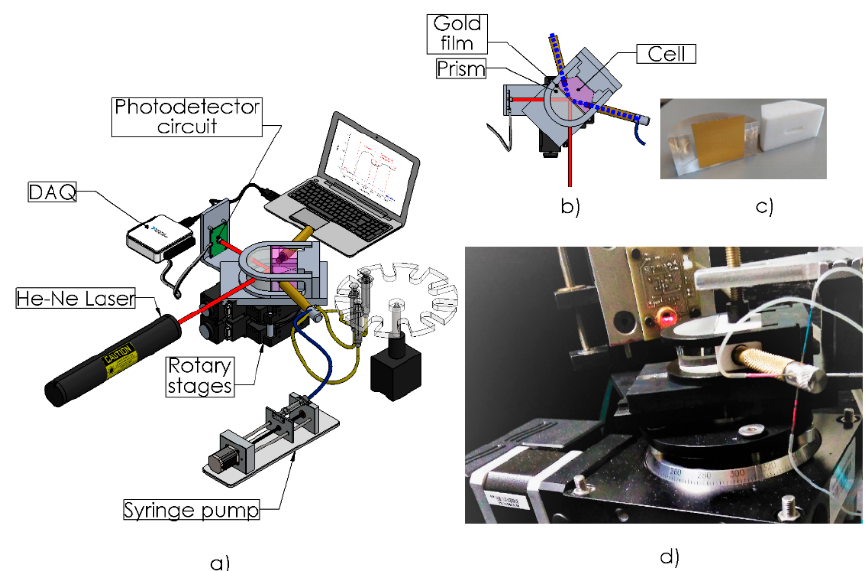
Figure 1. ( a ) SPR optomechanical setup; ( b ) Scheme of the Flow cell mount and ( c ) Teflon cell with gold film adhered to prism; ( d ) connections to the injection system.